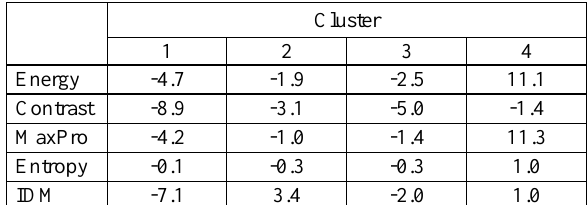
Figure 6. Nearest neighbour classification apply on Nanning Spatially displayed on maps (Figure 5 and Figure 6),